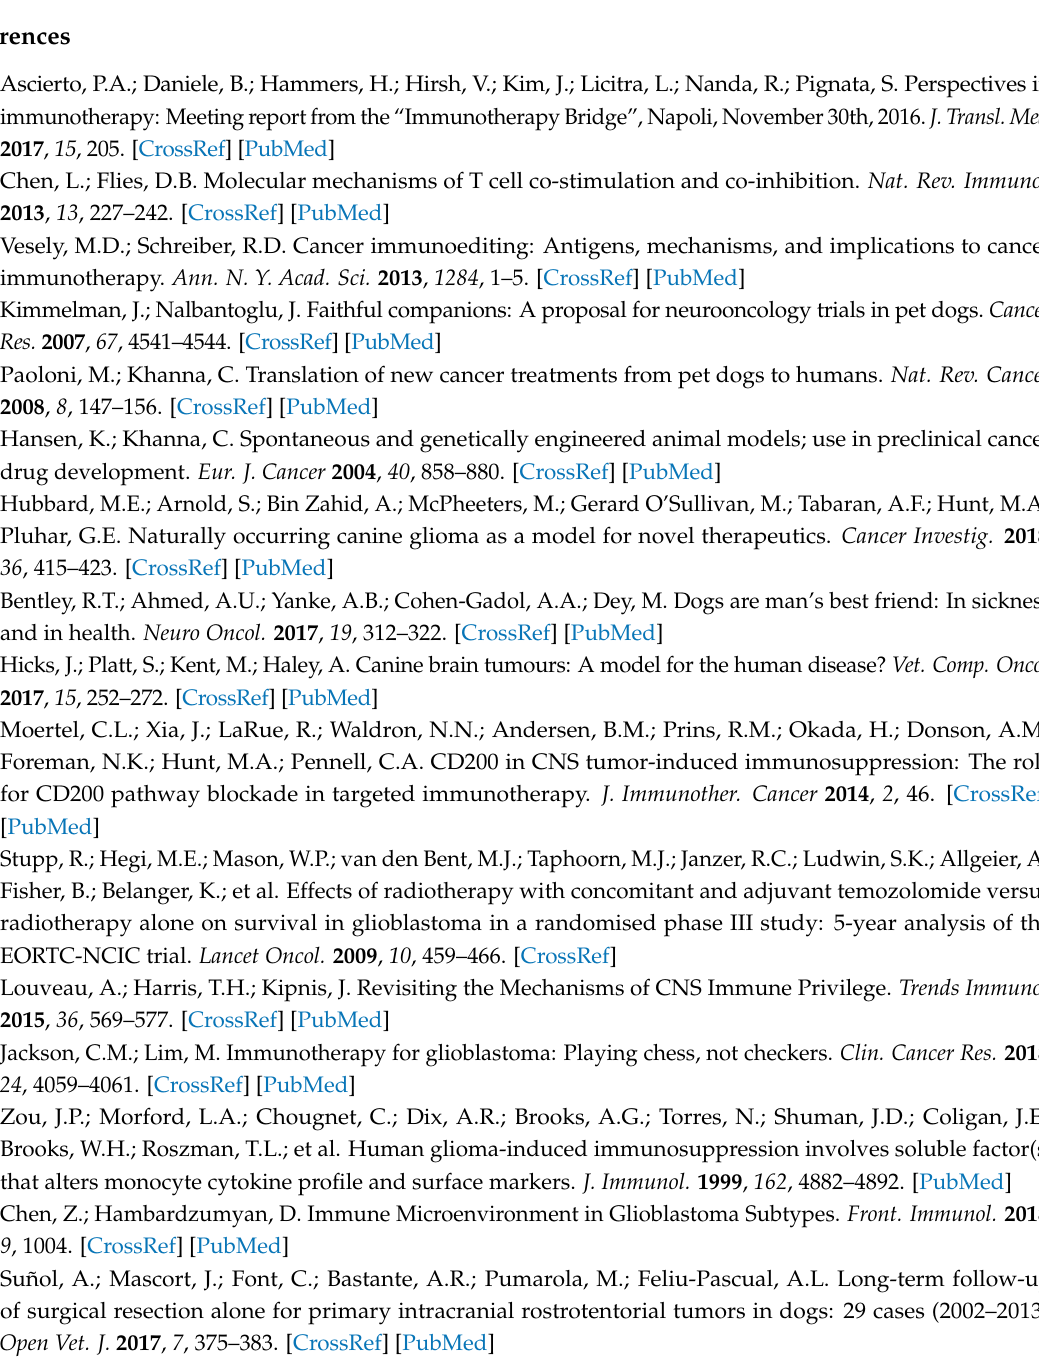
Figure S1: Canine Treatment